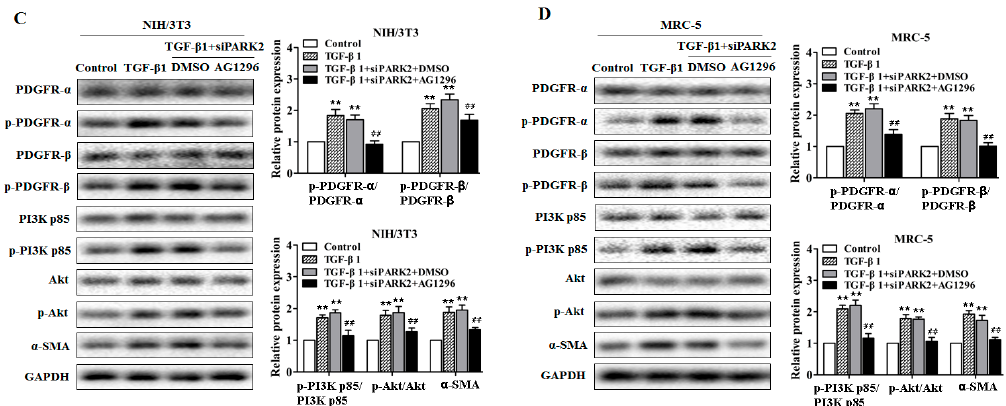
Figure 7. PARK2 knockdown activates PDGFRs/PI3K/AKT signaling pathway and α -SMA expression in fibroblasts. ( A , B ) Western blot analysis of PDGFRs/PI3K/AKT signaling pathway and α -SMA expression in fibroblasts (NIH/3T3 and MRC-5) transfected with siPARK2 or si-NC then treated with 2 ng/mL TGF- β 1 for 48 h, with ** p < 0.01 vs. the control group and ## p < 0.01 vs. the TGF- β 1 plus si-NC group; ( C , D ) Western blot analysis of PDGFRs/PI3K/AKT signaling pathway and α -SMA expression in fibroblasts (NIH/3T3 and MRC-5) transfected with siPARK2, AG1296 (Abcam, ab141170, 15 mM) treatment was started at 12 h post-transfection then treated with 2 ng/mL TGF- β 1 for 48 h, with ** p < 0.01 vs. the control group and ## p < 0.01 vs. the TGF- β 1 plus siPARK2 plus DMSO group. All data are expressed as the mean ± SD of at least three independent experiments.